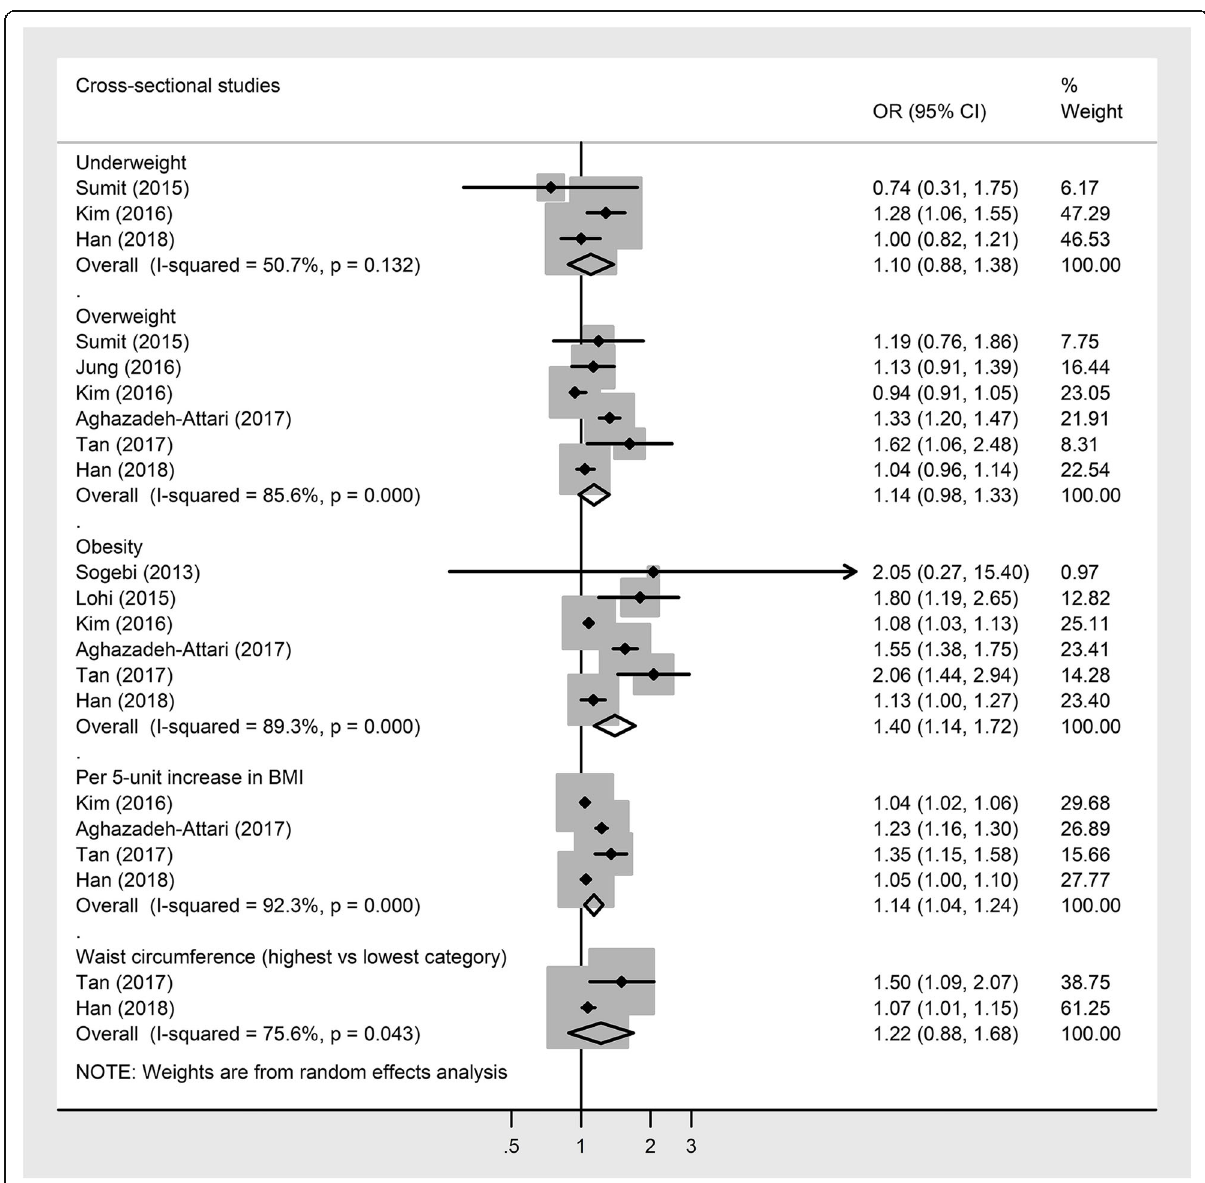
Fig. 2 Cross-sectional studies investigating the association between BMI or WC and the odds of having hearing